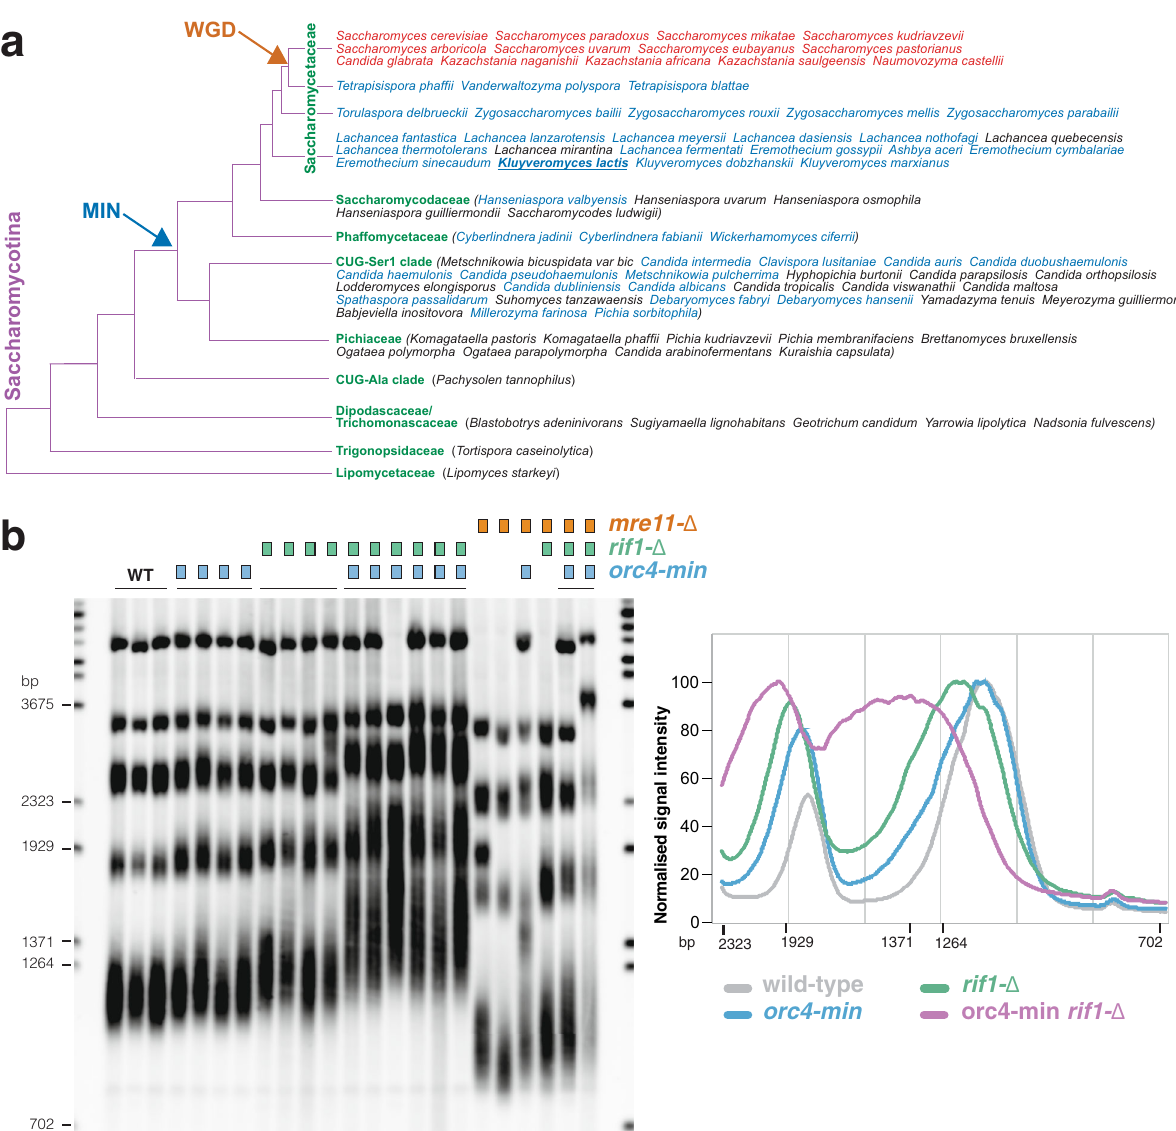
Fig. 6 The MIN motif of K. lactis Orc4 suppresses telomere elongation. a Phylogenetic tree of the Saccharomycotina, adapted from ref. 74 . Only species for which a search for Rif2 and/Orc4 was carried out are included. Species bearing Rif2 are in red; in all cases, Rif2 has MIN domain, whereas Orc4 does not. Species bearing putative MIN domain in Orc4 are in blue, whereas those where MIN domain is not present in Orc4 are in black. All red- and blue- lettered species have their MIN sequenced reported in Fig. 1b. The occurrence of the whole-genome duplication (WGD) event during the evolution of the Saccharomycetaceae clade is indicated by the orange arrow, whereas the deduced appearance of the MIN motif in Orc4 within the Saccharomycotina is indicated by the blue arrow. Kluyveromyces lactis is underlined. b Southern blotting of Eco RI-digested DNA hybridised with a telomeric oligonucleotide for the indicated genotypes. A quanti fi cation of hybridization signals from this gel obtained with Image Gauge v4.1 (Fuji) is shown on the right panel; strains of identical genotypes were averaged together. Source data are provided as a Source Data fi